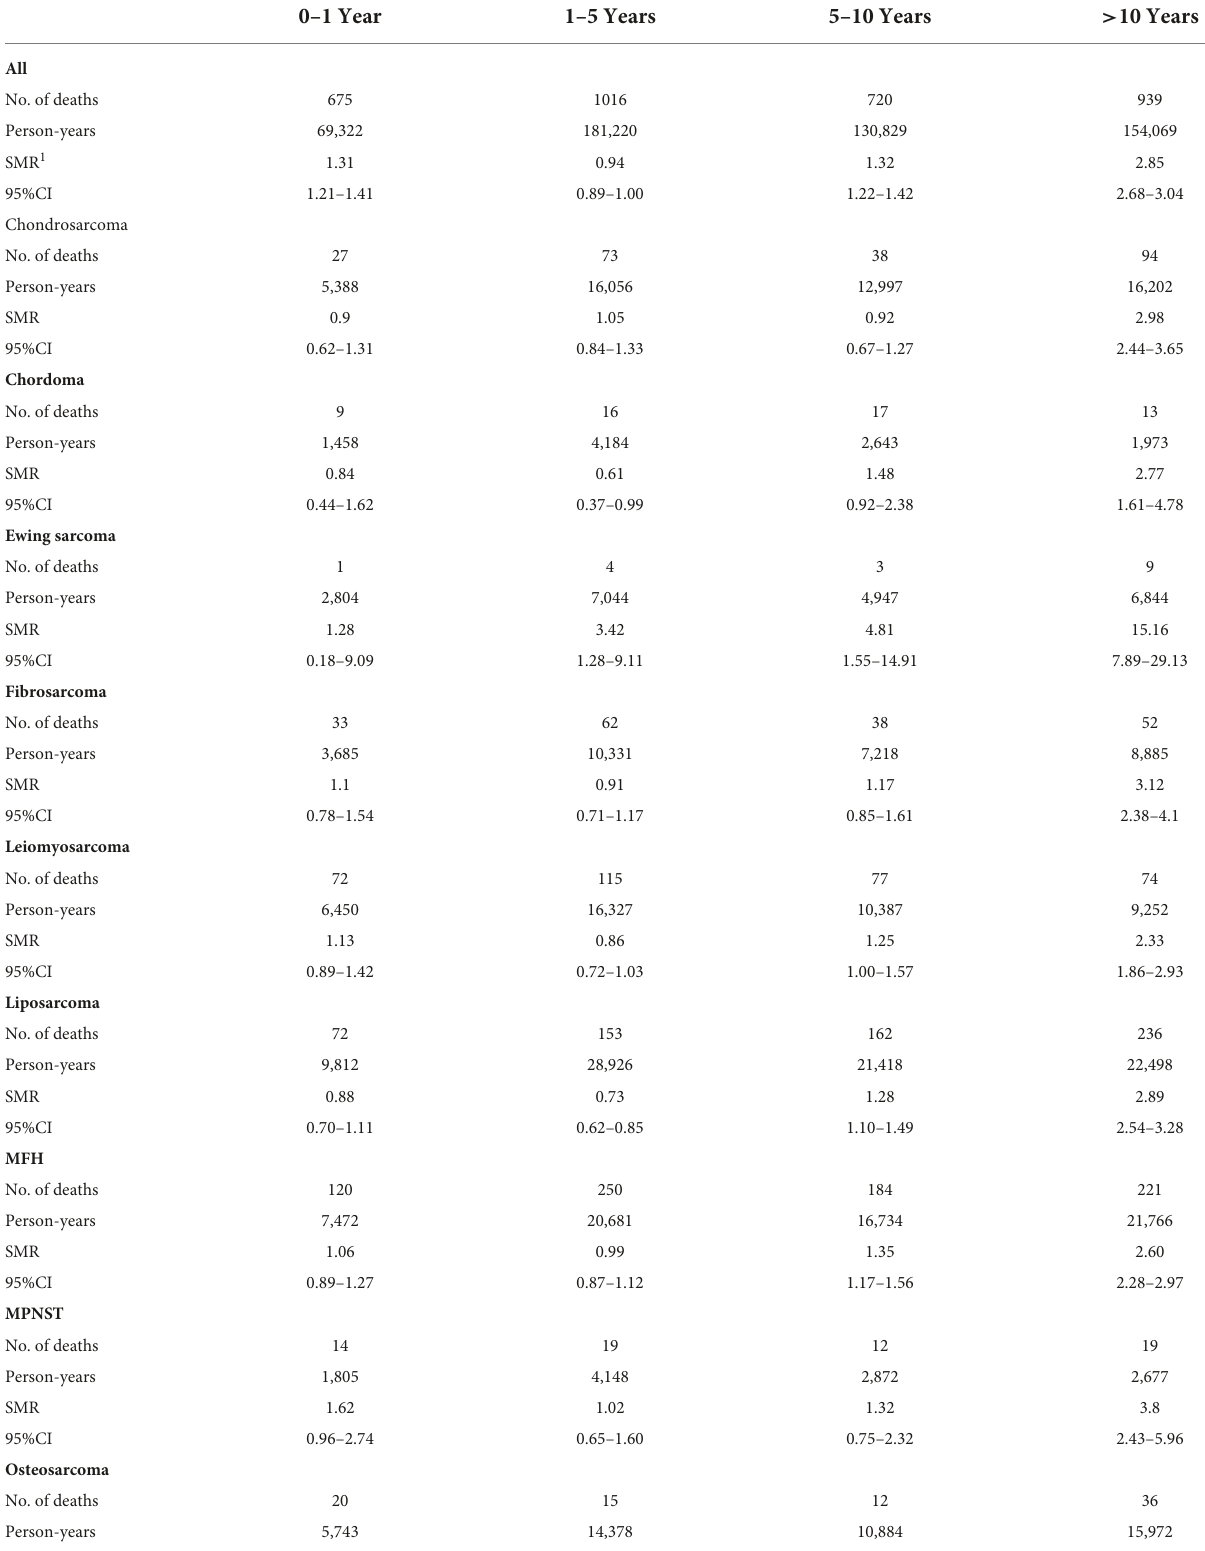
TABLE 4 Fatal HD among patients with sarcoma by histological subtypes and years since